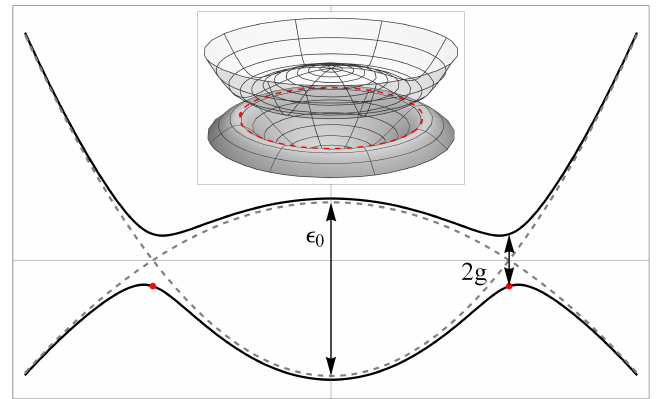
and ε v , the two bands in Eq. (1) k k and hybridization gap 0